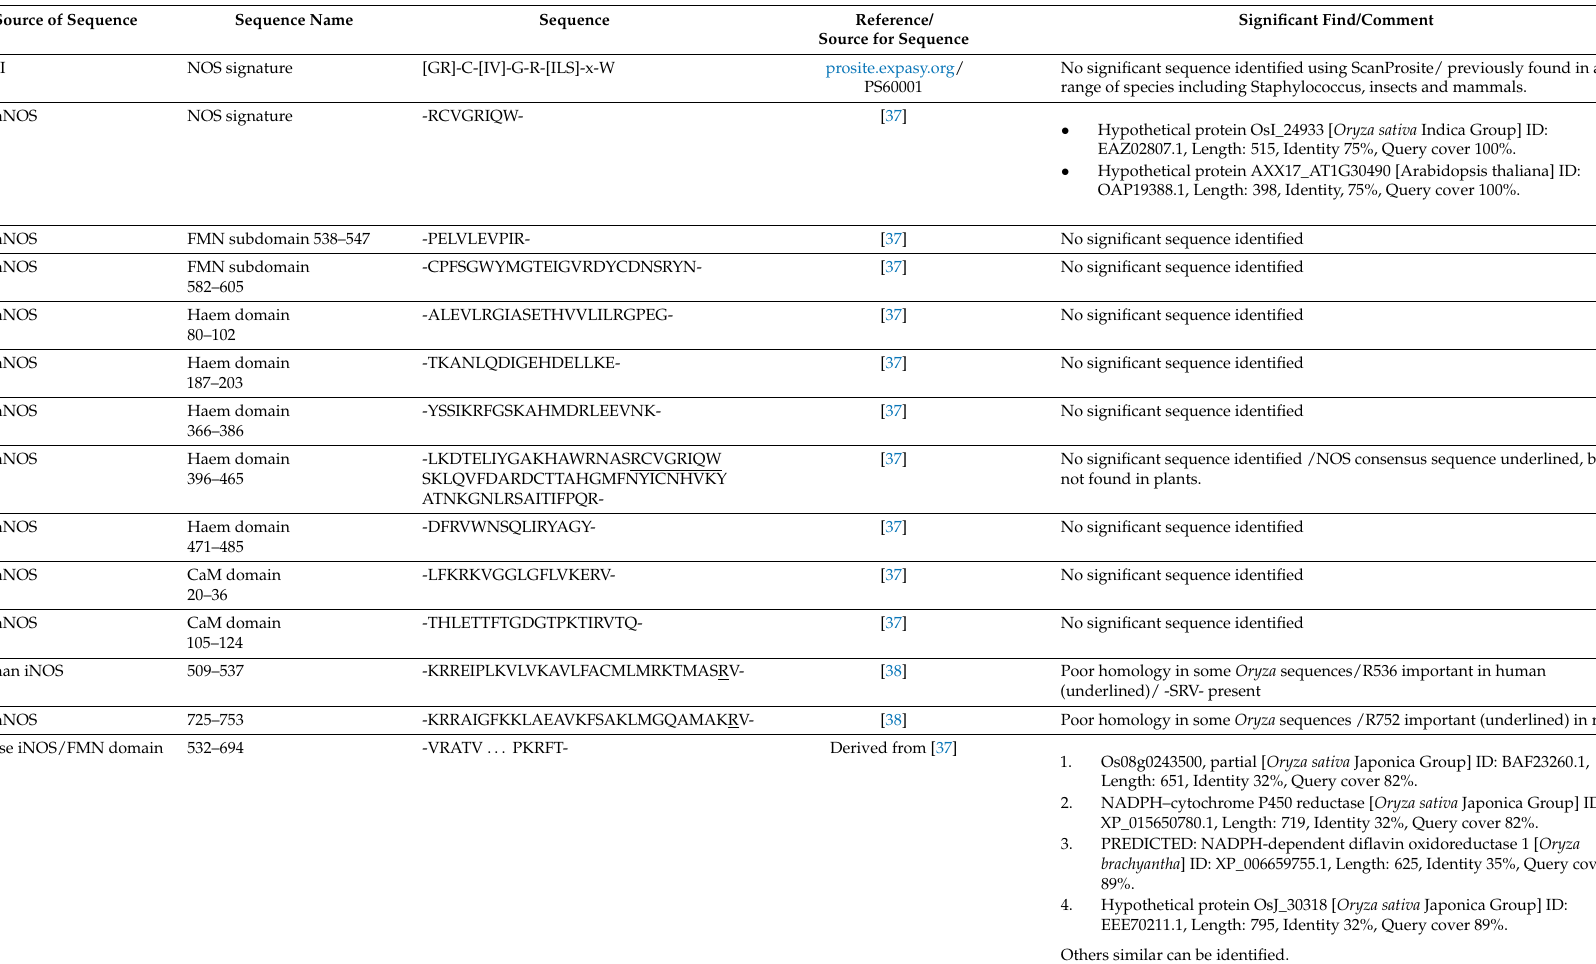
Table 1. Sequences used to search for matches in Arabidopsis and Oryza using Blastp and tBlastn. Areas used from the rat nitric oxide synthase (nNOS) sequence are highlighted in Figure